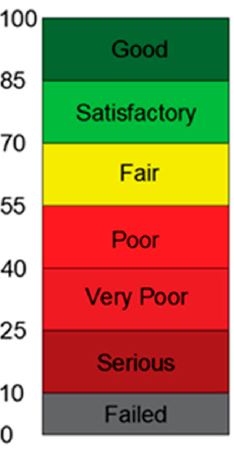
Figure 5. Standard PCI rating scale.